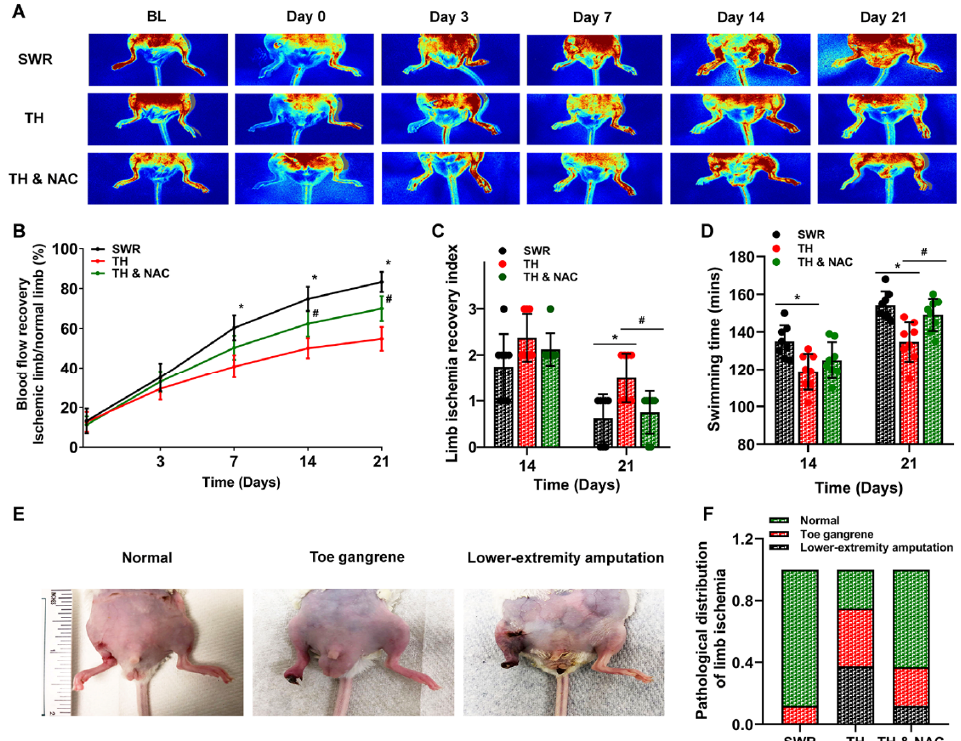
Figure 3. NAC treatment enhanced the recovery of blood flow and function of diabetic ischemic limb. Blood flow recovery as reflected by the ratio of ischemic limb (right hind limb)/non-ischemic limb (left hind limb) was significantly decreased in diabetic mice compared to non-diabetic mice at days 7, 14, and 21 after CLI (* p < 0.01, A , B ). NAC treatment significantly enhanced the recovery of blood perfusion of diabetic ischemic limbs at days 14 and 21 after CLI (# p < 0.01; A , B ). Function recovery of ischemic limb, as evaluated using a swimming endurance test and a semi-quantitative assessment of ambulatory impairment and limitation of the ischemic limb (modified clinical stand- ard score), was also significantly decreased in diabetic mice compared to non-diabetic mice at days 14 and 21 (* p < 0.05; C , D ). NAC treatment significantly enhanced functional recovery of diabetic ischemic limbs at day 21 (# p < 0.05; C , D ). In addition, the rate of limb amputation was markedly increased in diabetic ischemic limb compared to the non-diabetic, and NAC treatment prevented the increase of limb amputation in diabetic ischemic limb ( E , F ). BL, before ligation; TH, diabetic TALLYHO/JngJ mice with CLI operation; SWR, non-diabetic SWR/J mice with CLI operation; TH & NAC, TALLYHO/JngJ mice with CLI operation plus NAC treatment. All data are shown as means